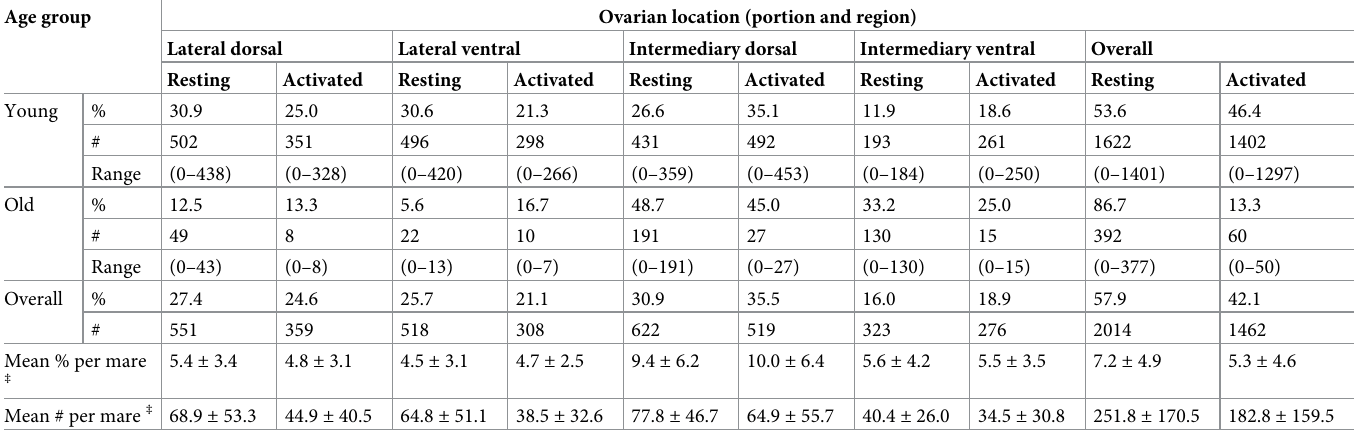
Mean # per mare ‡ 68.9 ± 53.3 ‡ No differences ( P > 0.05) were observed between ovarian locations within the same developmental stages, between developmental stages within the same ovarian locations, or when ovarian locations were pooled (overall) between developmental stages. A total of 206 histological sections were evaluated (25.8 ± 1.1 sections per mare). Descriptive percentages were calculated within a row for the same age group and developmental stage. All mean data were analyzed using one-way ANOVA after arc sin square root transformation for percentage data or log 10 transformation for non-percentage